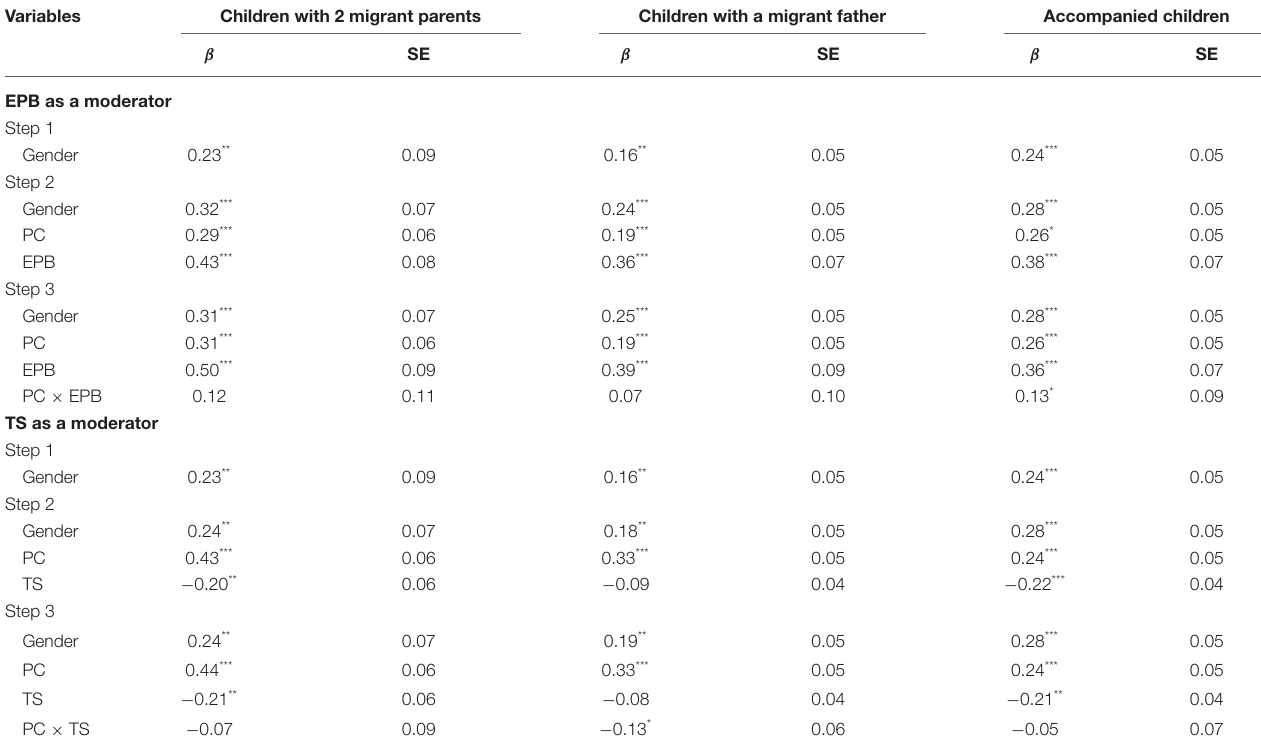
TABLE 3 | Summary of hierarchical regression analyses for the relationship between psychological control and anxiety with externalizing problem behavior/teacher support included as a moderator. Variables